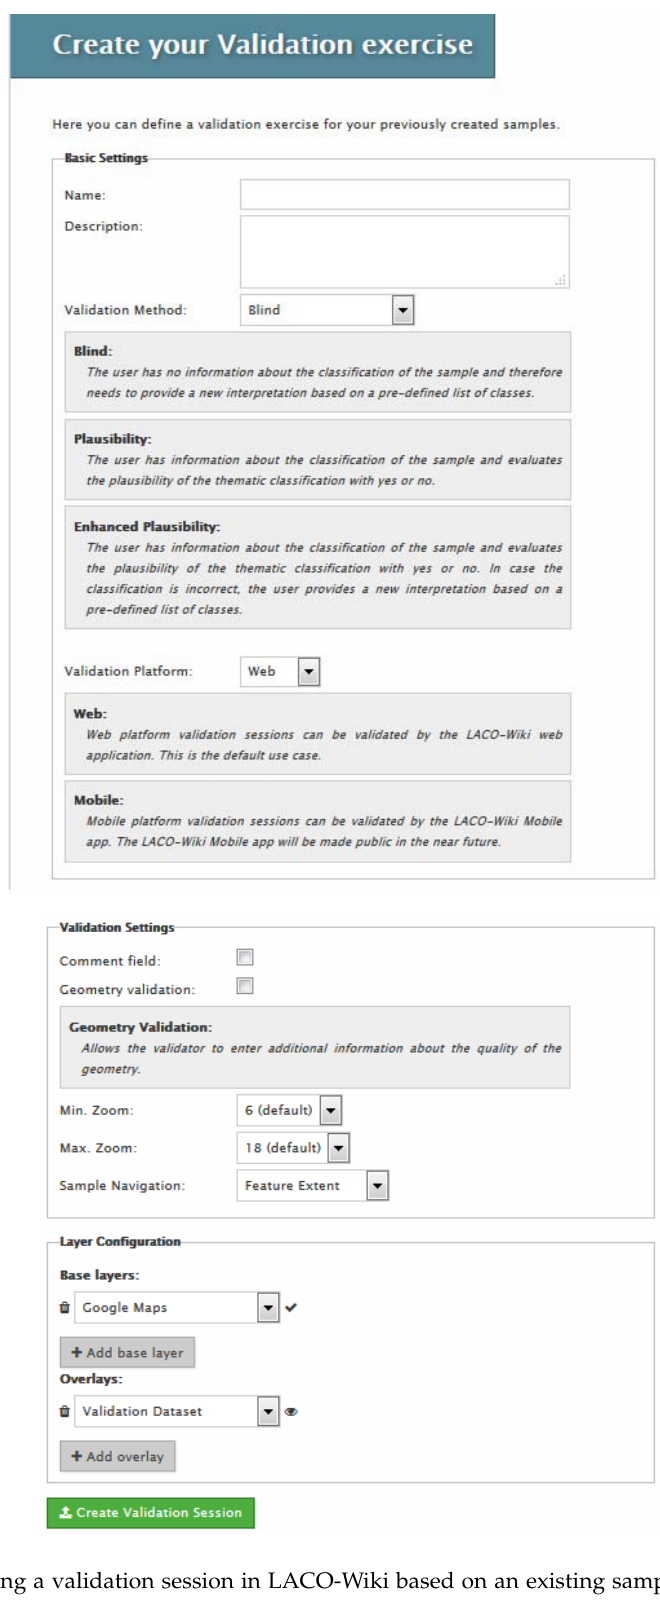
Figure 7. Creating a validation session in LACO-Wiki based on an existing sample. This involves providing a name, a description, choosing the type of validation (blind, plausibility, enhanced plausibility), whether this is for an online or mobile session, the validation settings, which include additional fields such as a comment box or whether the user should judge the positional accuracy, and what base layers should appear in the validation session, e.g., Google Maps, Bing Maps, etc.